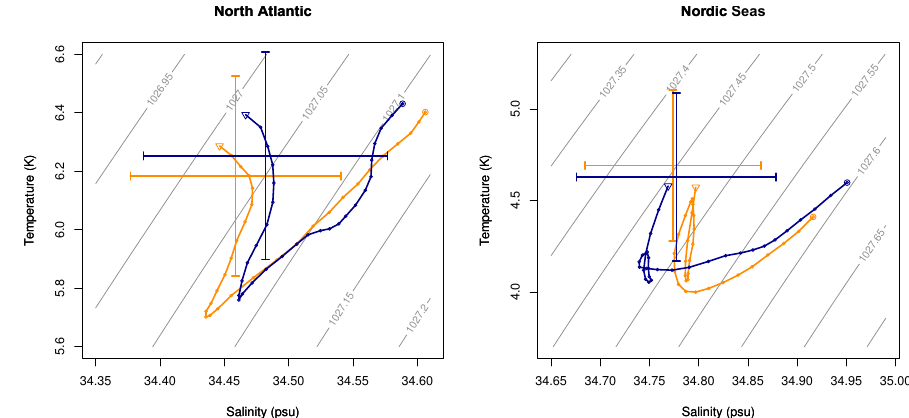
Figure 4. Temperature and salinity averaged over the upper 220m for two deep water formation regions: the North Atlantic and Nordic Seas. The deep water formation regions cover all grid cells with an annual mean mixed layer depth ≥ 250m in the corresponding ocean basins. The lines show the salinity and temperature development from the beginning (triangle) to the end (large dot) of the SRR for the S2_CHEM (orange) and S2_NOCHEM (blue) experiments. Each point represents a single year. To improve visibility, the values are smoothed using a 15-year low-pass filter. Error bars denote the mean and the standard deviation of the corresponding control ensembles. Contours represent the water density.